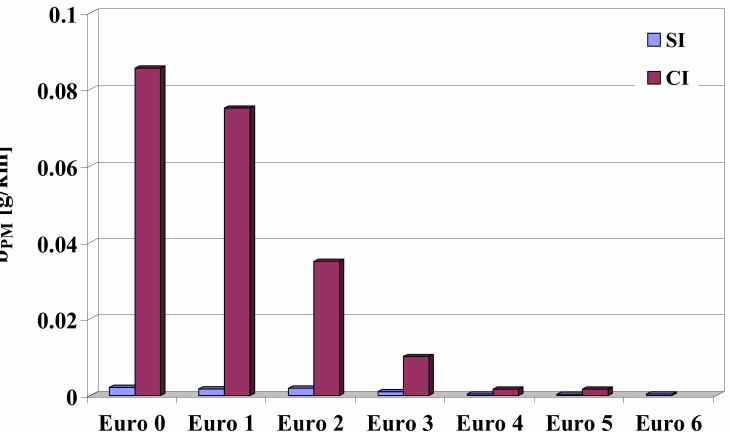
Figure 15. Specific distance emission of particulate matter—b PM , from hot passenger car engines of Euro 0–Euro 6 pollutant emission categories, spark-ignition engines—SI and compression-ignition engines—CI, under the model vehicle traffic conditions.